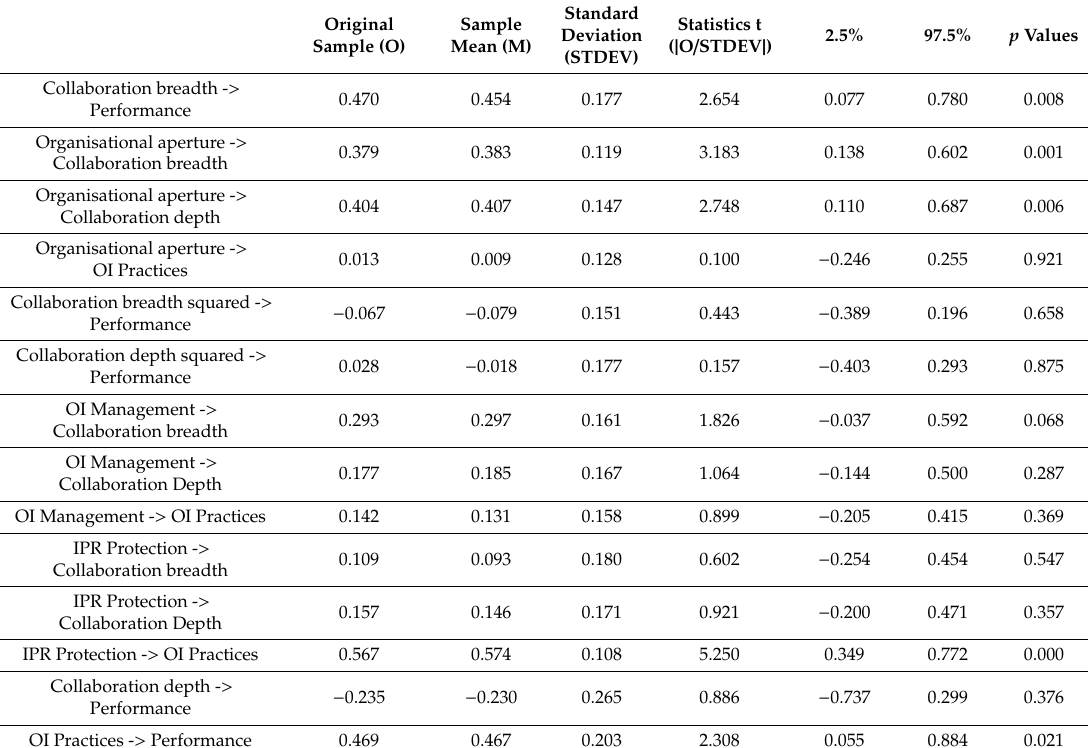
Table 18. Quadratic e ff ect of collaboration depth and breadth in performance.